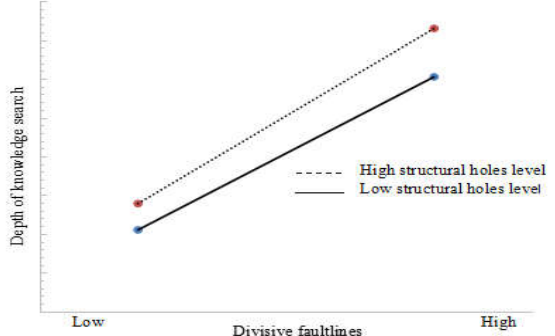
Figure 2. The moderating effect of structural holes on divisive faultlines and the depth of the knowledge search.